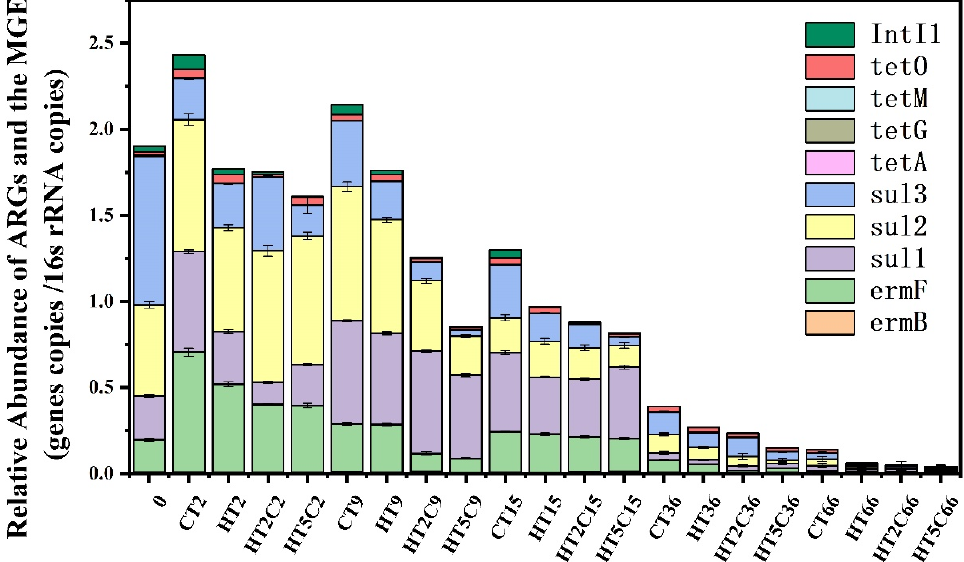
Figure 2. Changes in the relative abundance of ARGs in different compost piles. Bars denote the standard errors. Table 1. Comparison of removal rates of relative abundance of each ARG by adding different additives (over 66 d). Treatments ermB